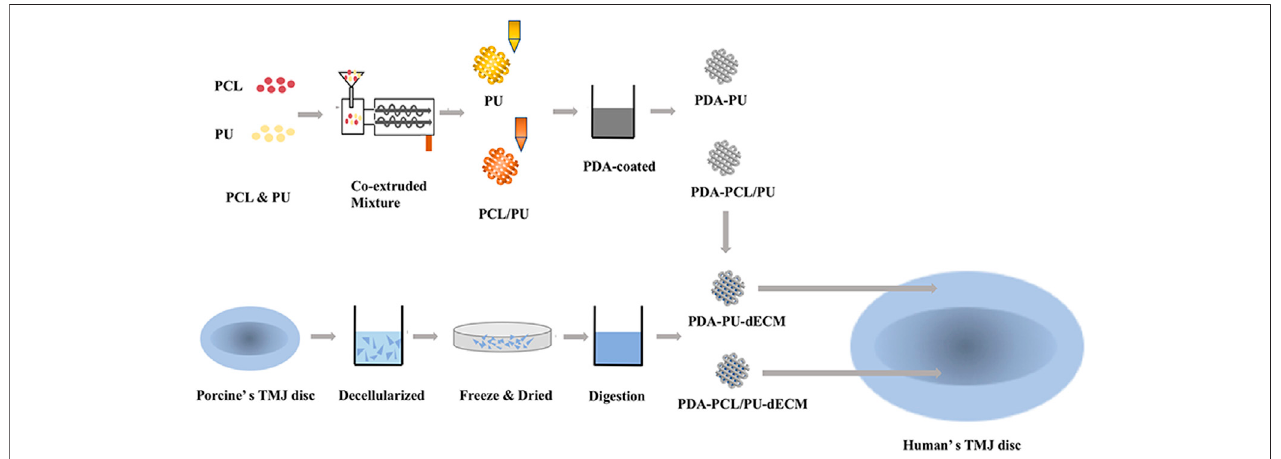
FIGURE 1 | Schematic illustration of the construction process of the composite scaffolds of the experimental